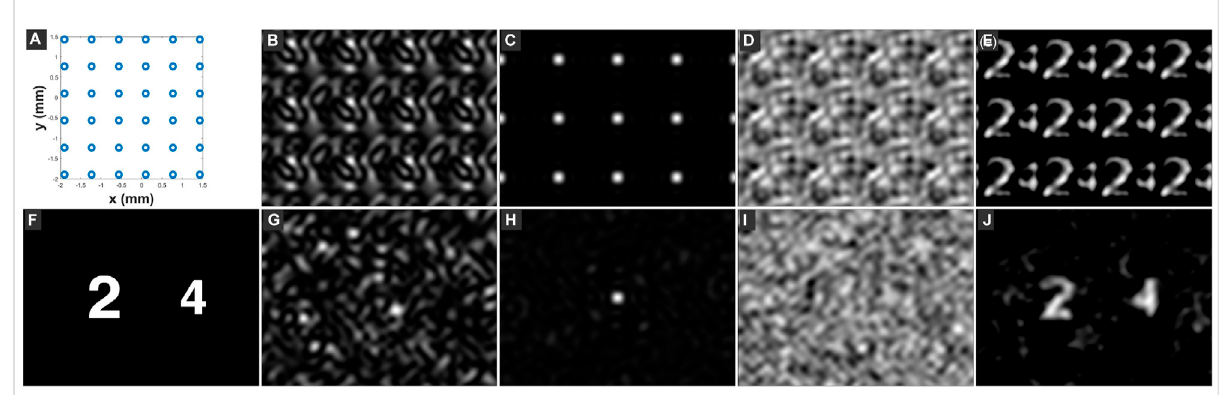
FIGURE 6 Simulations for periodic antennas and the randomized antennas. The fi rst row exhibits the properties of the periodic antennas: (A) antenna arrangement; (B) speckle pattern generated by the periodic antennas; (C) PSF; (D) C P ; and (E) recovered image Δ G (2) . (F) Ground truth of the image. The last four sub- fi gures are of the randomized antennas described in Figure 2: (G) speckle pattern; (H) PSF; (I) C P ; and (J) recovered image Δ G (2)